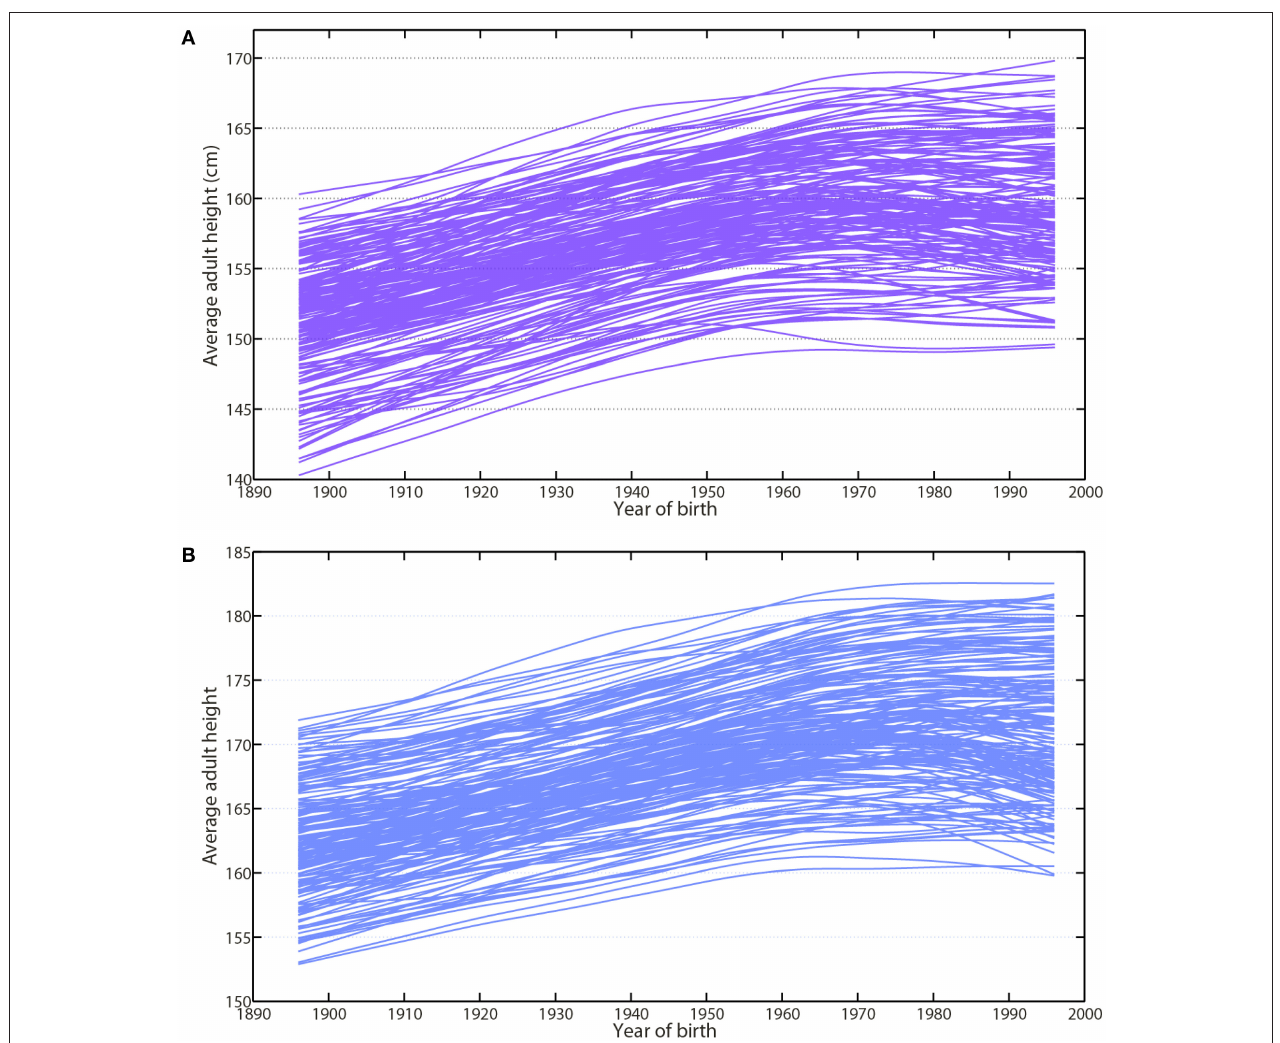
FIGURE 3 | Average adult height has followed a similar pattern toward a plateauing trend since 1980. The analysis of the growth patterns reveals that the gain in height during the last century is not a linear process. During the last 3 decades, data have shown a similar plateauing state in the tallest populations among women and men of high-income countries from North America to Europe. This recent asymptote suggests a potential upper limit to human height. (A) Average adult height of women (violet-purple) represented for each country from 1914 up to 2014. (B) Average adult height of men (blue) represented for each country from 1914 up to 2014. Data are compiled from NCD-RisC and available by country on their website